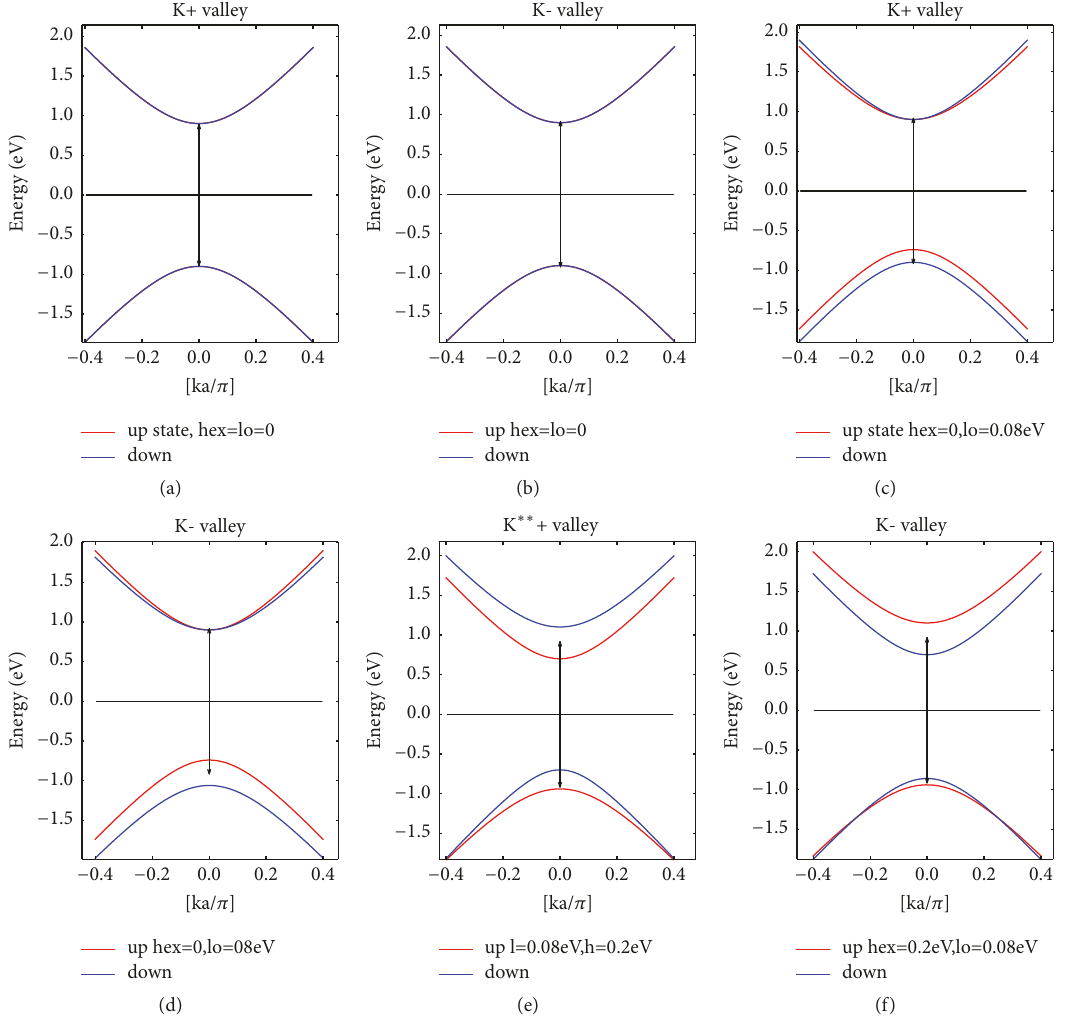
Figure 1: Electronic band structure near valley 𝐾 ± : (a) and (b) for zero both spin-orbit coupling and exchange field (lo=hex=0), (c) and (d) for spin-orbit coupling(lo=0.08 eV,) and zero exchange field, and (e) and (f) for spin-orbit coupling (lo=0.08 eV) and exchange field (hex=0.2 eV). Red: spin-up electron (hole) states, blue: spi- down electron (hole) states, right panel for 𝐾 + , and left panel for 𝐾 −